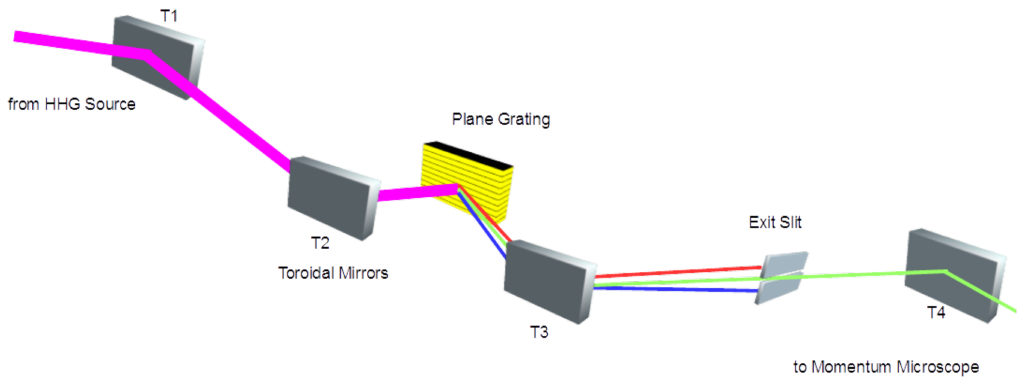
Figure 12: Ju SPARC_SIRIUS beamline. The XUV light, produced in the HHG process for photoemission, is monochromatized and transported to the momentum microscope.